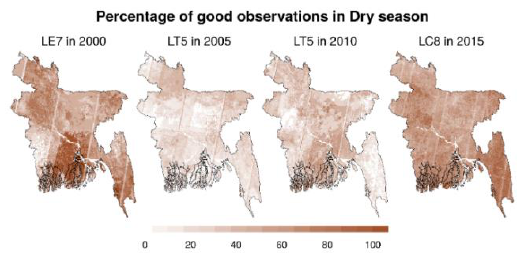
Figure 1. Percentage of cloud-free observations available for LE7, LT5, and LC8 for corresponding